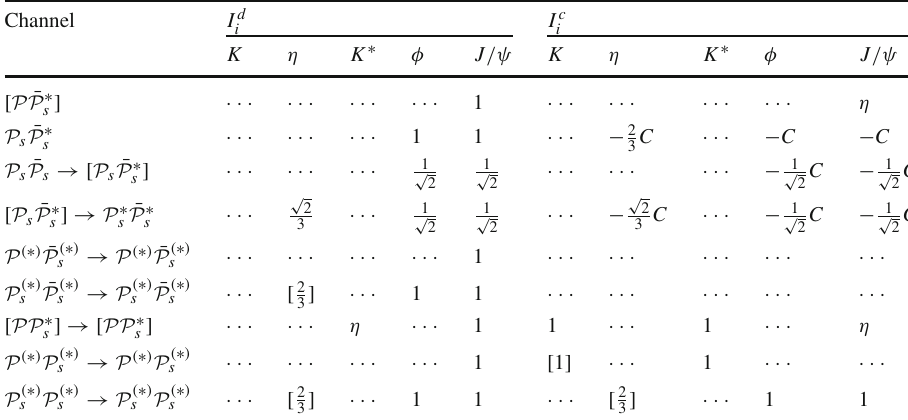
Table 1 The isospin factors I d and I c for direct and cross i diagrams and different exchange